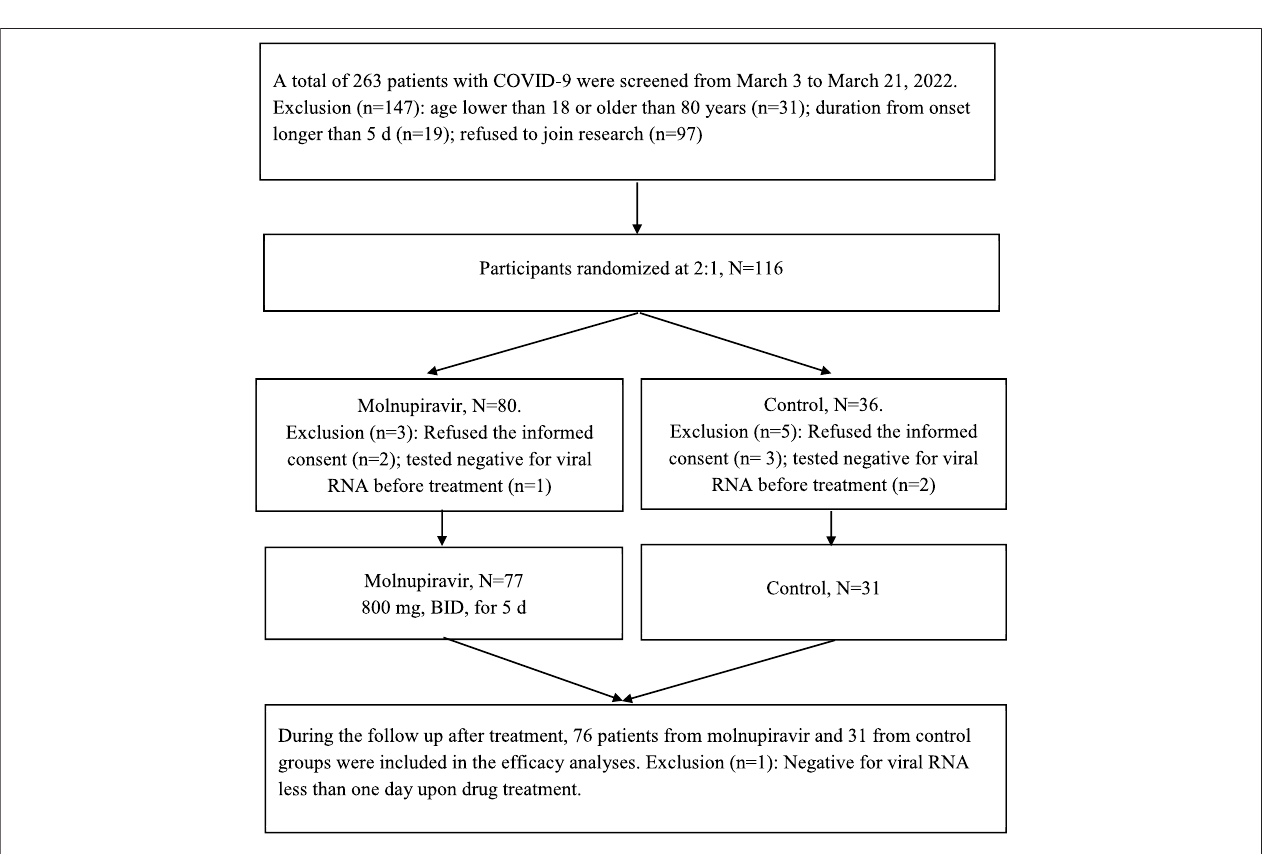
FIGURE 1 | CONSORT diagram for this